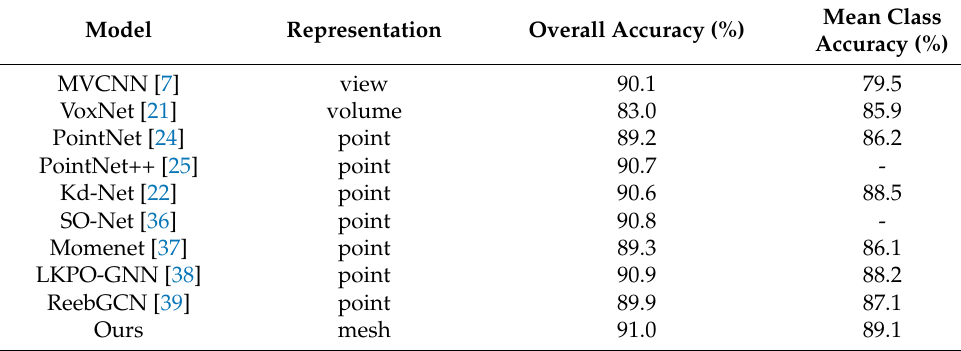
Table 2. Comparison of classification results on